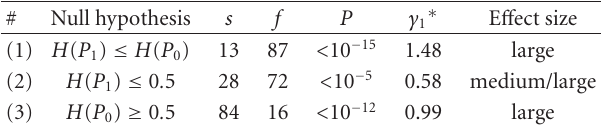
Table 3: Hypothesis tests where s and f are the number of success and failures for trials 1–100.